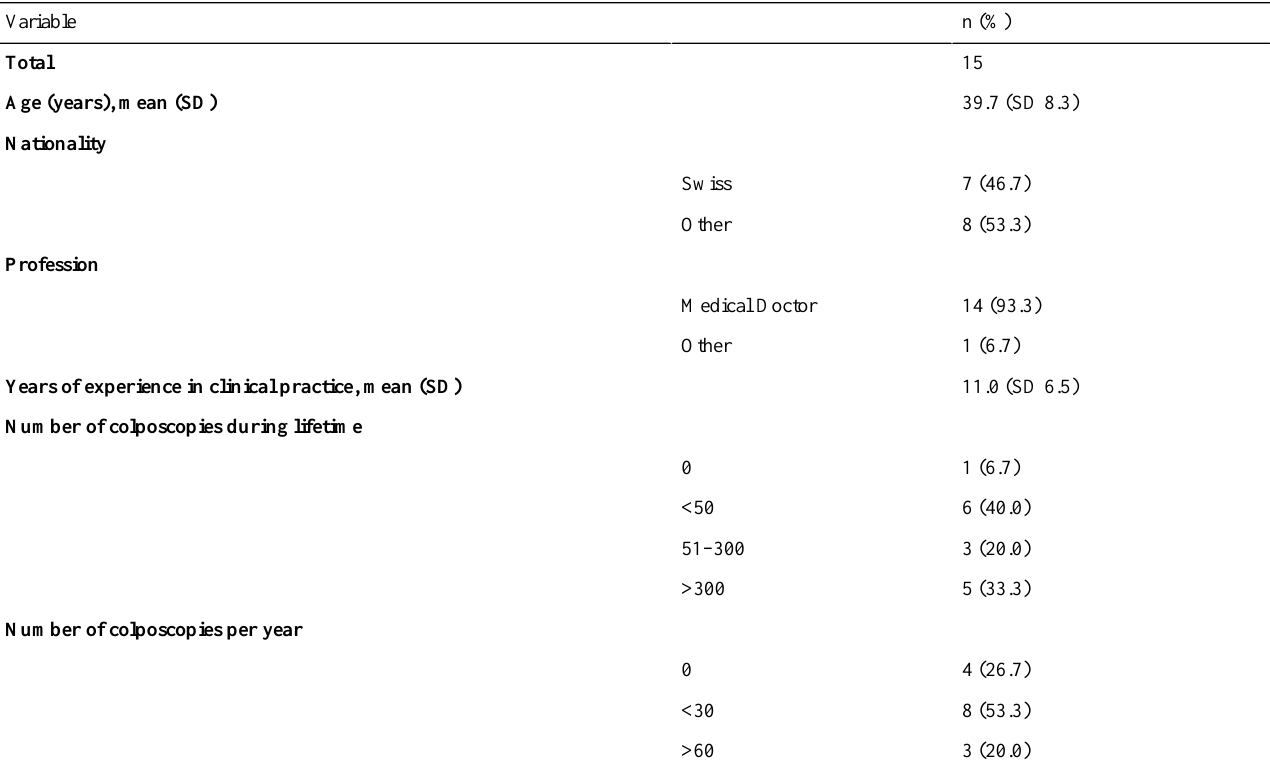
Table 1. Raters’sociodemographic